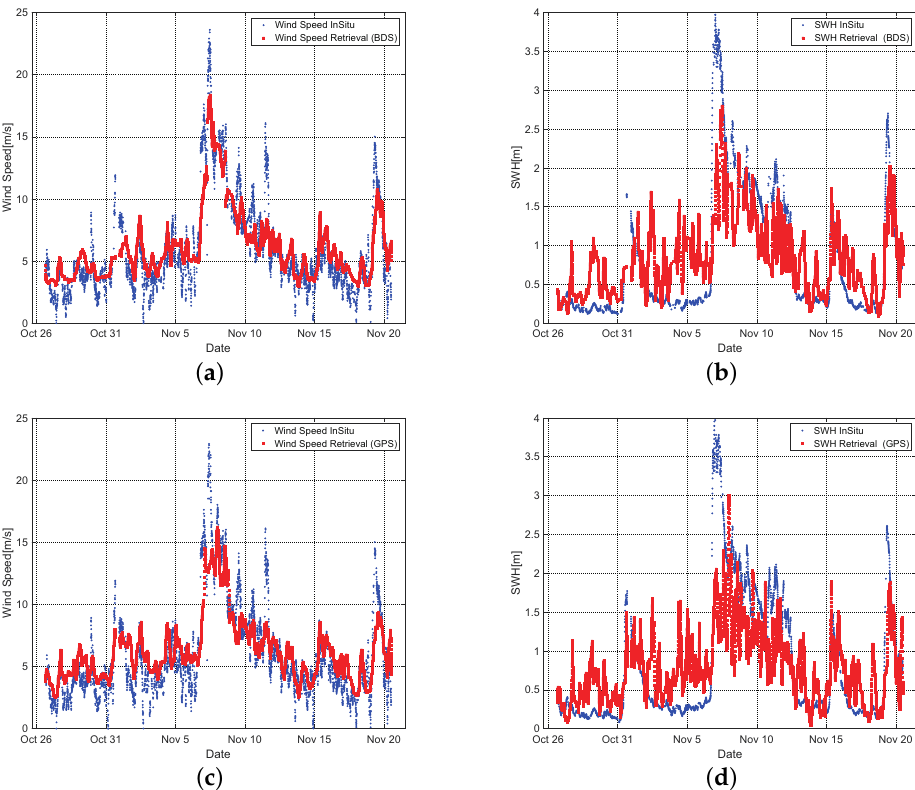
Figure 16. Retrieval results using Beidou system and GPS system, respectively: ( a ) Wind speed results using Beidou system; ( b ) Significant wave height results using Beidou system; ( c ) Wind speed results using GPS system; ( d ) Significant wave height results using GPS